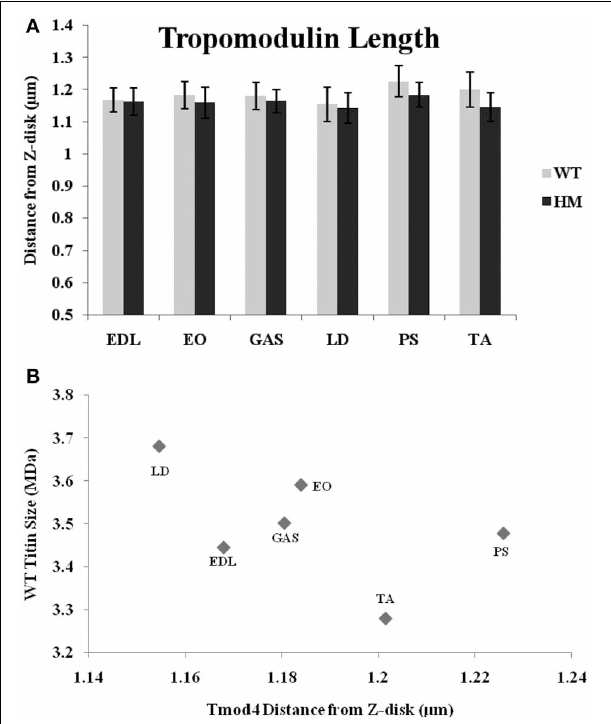
FIGURE 5 | (A) Tropomodulin determination of thin filament lengths in different muscles and rat genotypes. See Figure 3 for muscle and genotype abbreviations. (B) Relationship between titin size and tropomodulin estimated thin filament length.